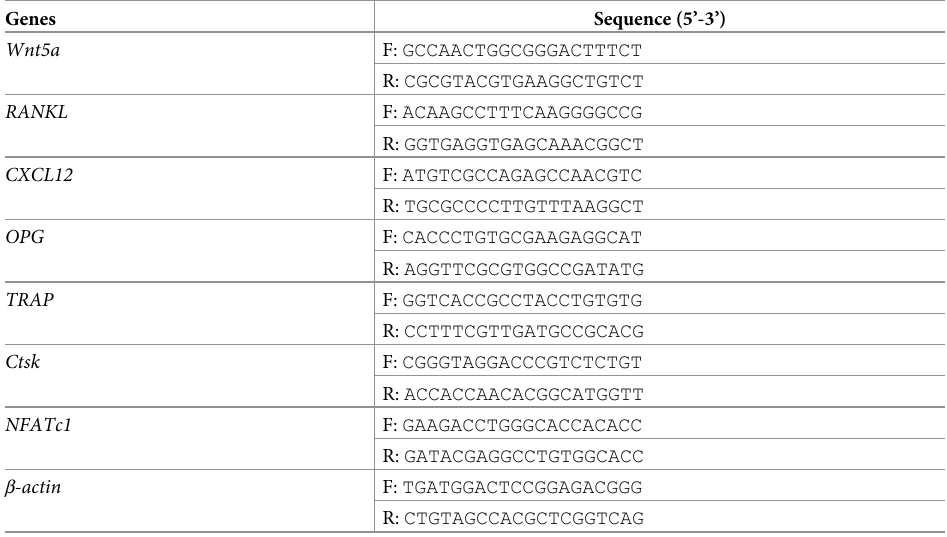
Table 1. Primer sequences for reverse transcription-quantitative polymerase chain reaction.